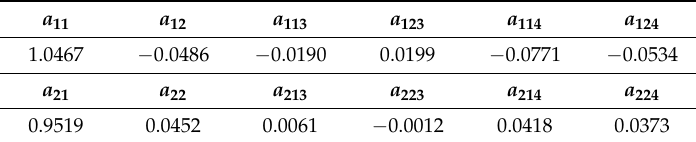
Table 1. The parameters of the equivalent model.